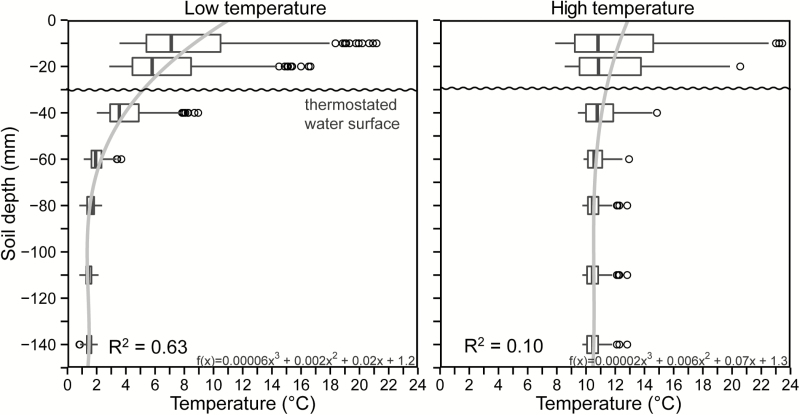
Polynomial temperature profiles (grey line) in cold-treated (left) and warm-treated (right) plant cylinders calculated during measurements of RERs. Data of the three cold water baths were averaged. Boxplots display the hourly temperature readings for each sensor depth. Boxes comprise the 25–75 % quantiles with the median as vertical line, dots indicate outliers. The deepest temperature sensor was located at −140 mm depth. Similar polynomial regressions were made for each RER 12 h−1 to estimate root tip temperatures.